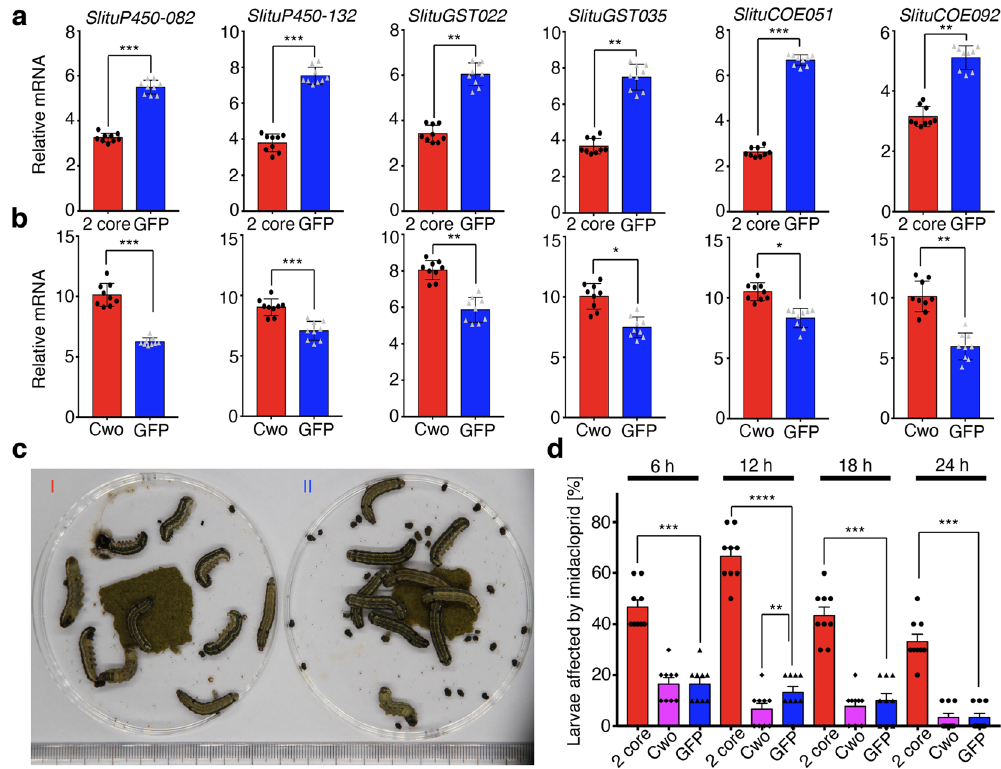
Fig. 4 Effects of knockdown of circadian core genes on expression of detoxi fi cation genes and imidacloprid sensitivity. Relative expression of detoxi fi cation genes was measured by RT-qPCR after injection with a combined siRNAs for SlituClk and SlituBmal1 ( “ 2 core ” , red) or siRNA for GFP (control, blue); and b siRNA for SlituCwo (red) or GFP (control, blue). c Effect of arti fi cial diet containing imidacloprid (30 μ g/g) on larvae after the injection of siRNA with [I] combined SlituClk + Bmal1 or [II] GFP as control. d Time course of imidacloprid sensitivity after knockdown. Larvae were fed arti fi cial diet supplemented with imidacloprid (30 μ g/g) 24 h after knockdown by siRNA injection; “ affected ” larvae were recorded every 6 h. Larvae were scored as “ affected ” when they rounded up and did not move or feed and excreted shapeless feces. Several hours later, some recovered from this “ suspended ” state and some died. Three groups of 10 6LD1 individuals were prepared for siRNA injection and each value represents the average of three experiments with SEM error bars. The level of statistically signi fi cant difference was set at * P value < 0.05, ** P value < 0.01, *** P value < 0.001 and **** P value <